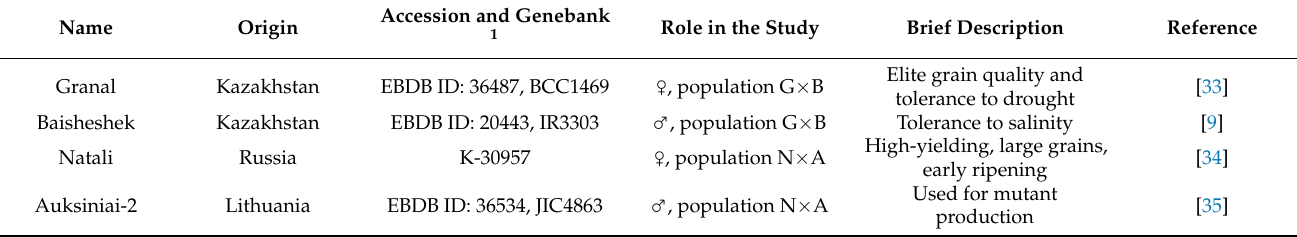
Table 2. Description of four spring barley cultivars used as plant material in this